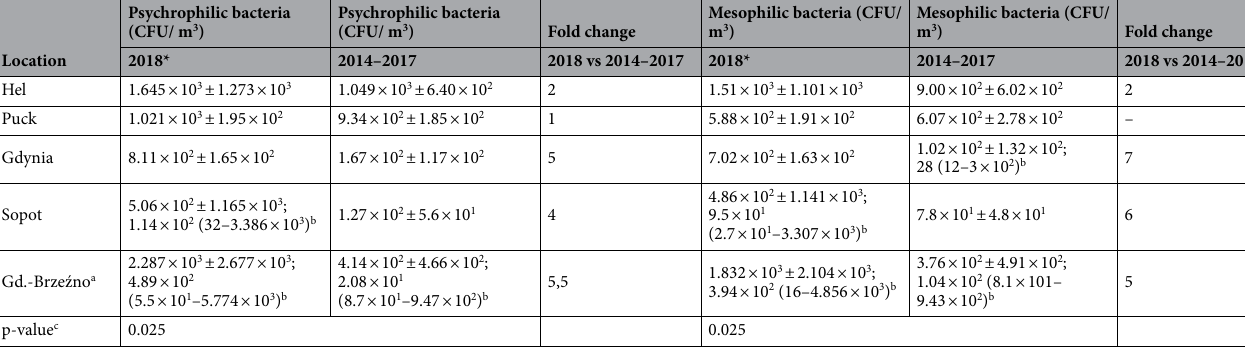
Table 4. The mean and standard deviation of concentration of psychrophilic and mesophilic bacteria (CFU/ m 3 ) in air over the Bay of Gdańsk in 2018 versus 2014–2017. a Gd.-Brzeźno—it is an abbreviation of the town name Gdańsk-Brzeźno, b in case of a higher standard deviation than the mean, the median and range (min–max) was calculated, c Friedman test, α-0.05, *The results marked in grey colour have been published in preliminary study 36 .